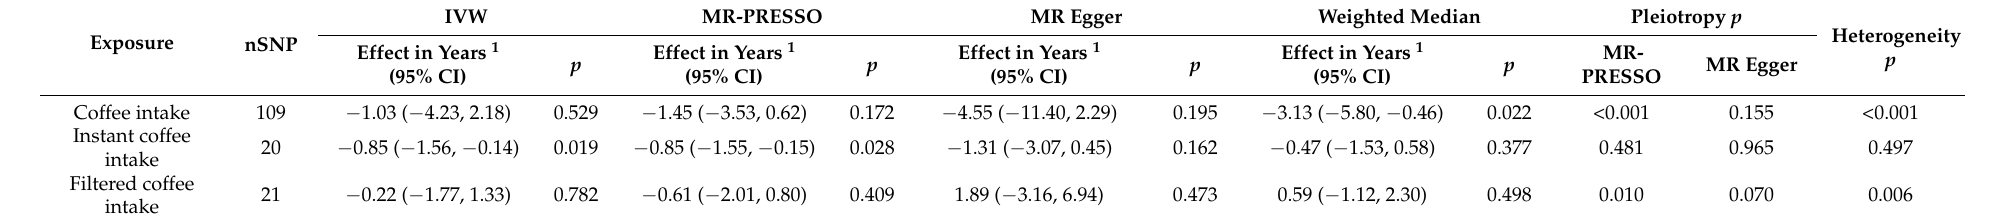
Table 3. Causal effects of coffee consumption on telomere length estimated by Mendelian